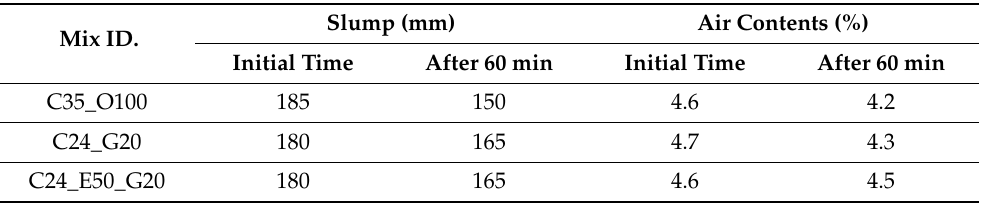
Table 8. Fresh properties of